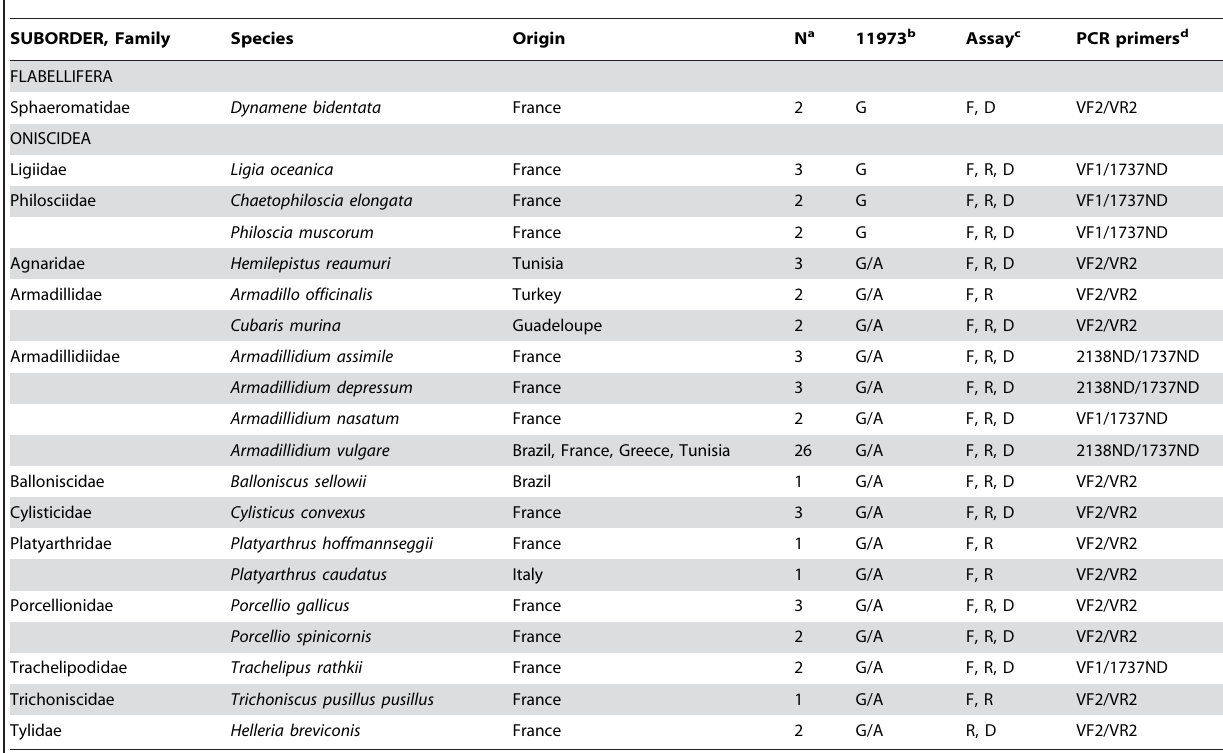
Table 1. Distribution of the 11973G/A mitochondrial heteroplasmy in 20 isopod crustacean species.